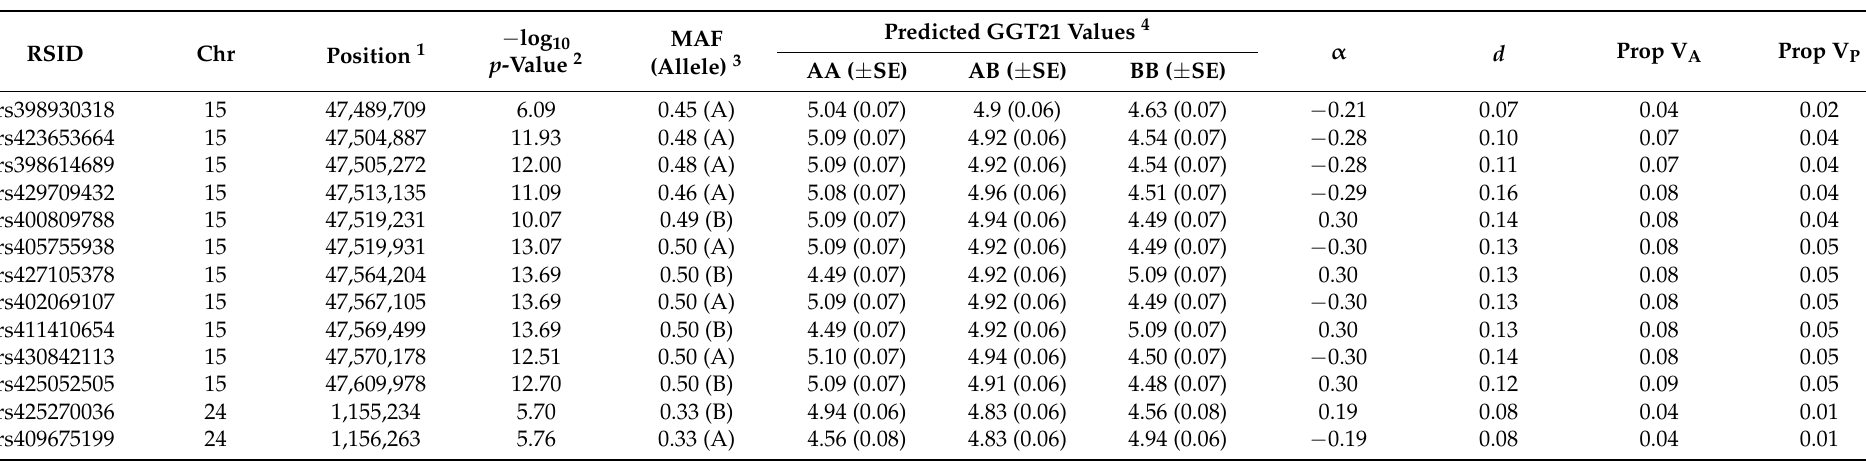
Table 1. SNPs that reached genome-wide significance levels for Facial Eczema tolerance. EMMAX p -values, predicted log-transformed GGT21 values, allele substitution effects ( α ), dominance effects ( d ) and proportion of total additive (V A ) and phenotypic (V P ) variance explained by each marker.